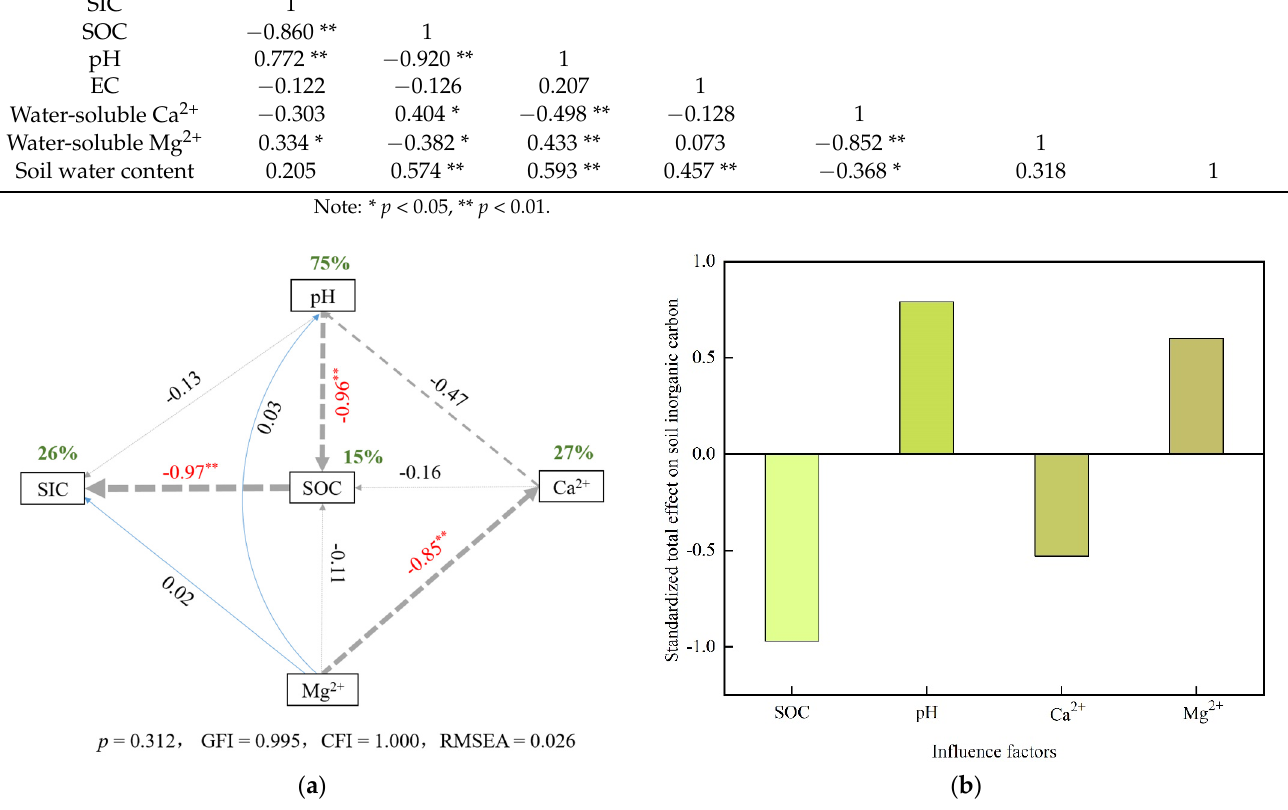
Figure 7. SEM model analysis of SIC and soil physicochemical properties in poplar plantations ( a ) and the standardized total effects ( b ). SEM model analysis ( a ) explains the direct or indirect effects of soil physicochemical properties on SIC content; the SEM model was used to calculate the standardized total effect (direct effect + indirect effect) ( b ). Gray dashed arrows are negative correlations and blue solid arrows are positive correlations; the numbers next to the lines represent the standardized path coefficients and the arrow widths are proportional to the magnitude of the path coefficients. Red numbers represent significant differences ( ** p < 0.01).